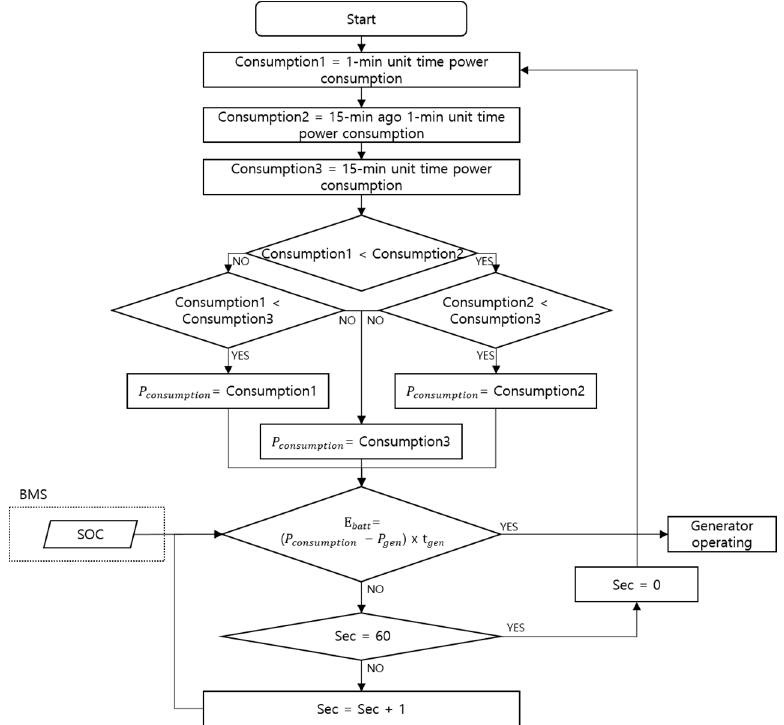
Figure 13. Flowchart of the proposed